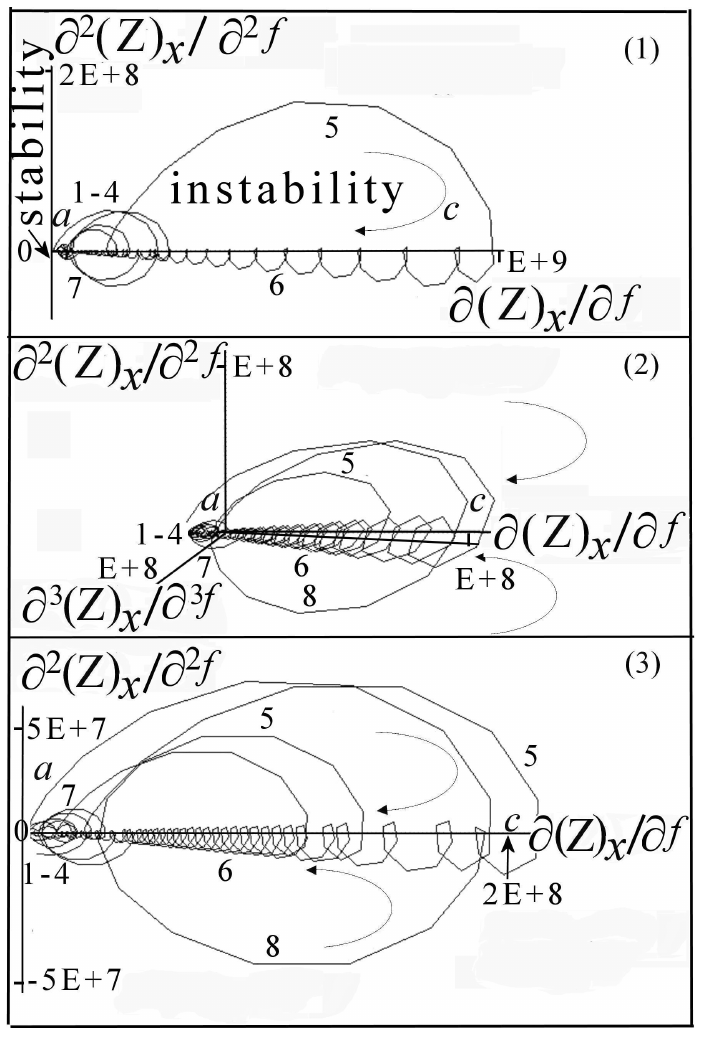
Figure 11. Phase-space derivative on the diverging loops and converging spirals (events 5–8) in the region of peak A. Views ( 1 – 3